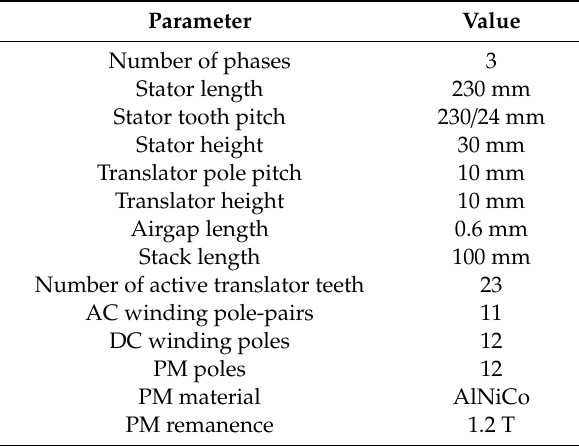
Figure 2. The proposed machine configuration. ( a ) 2-D view. ( b ) 3-D partial view. Table 1. Specifications of the proposed motor.